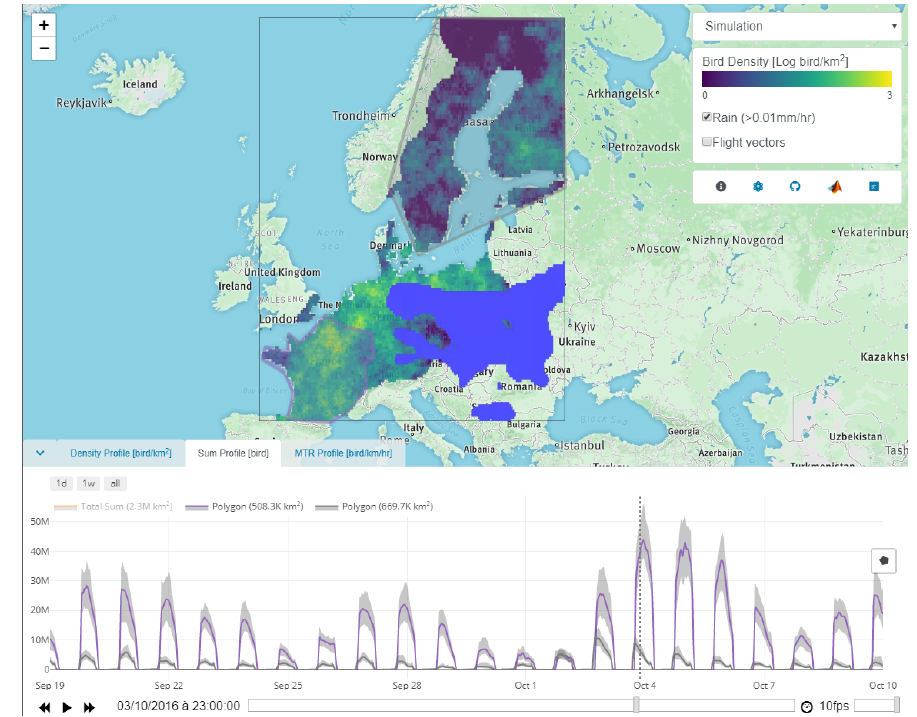
Figure A11. Print-screen of the web interface with the simulation map for the 3 October 2016 at 23:00. The bottom pane shows the time series of the total number of birds within the color-coded polygon drawn on the map. The button with the polygon symbol on the right side of the time series allows to query the total number of birds flying within any polygon drawn on the